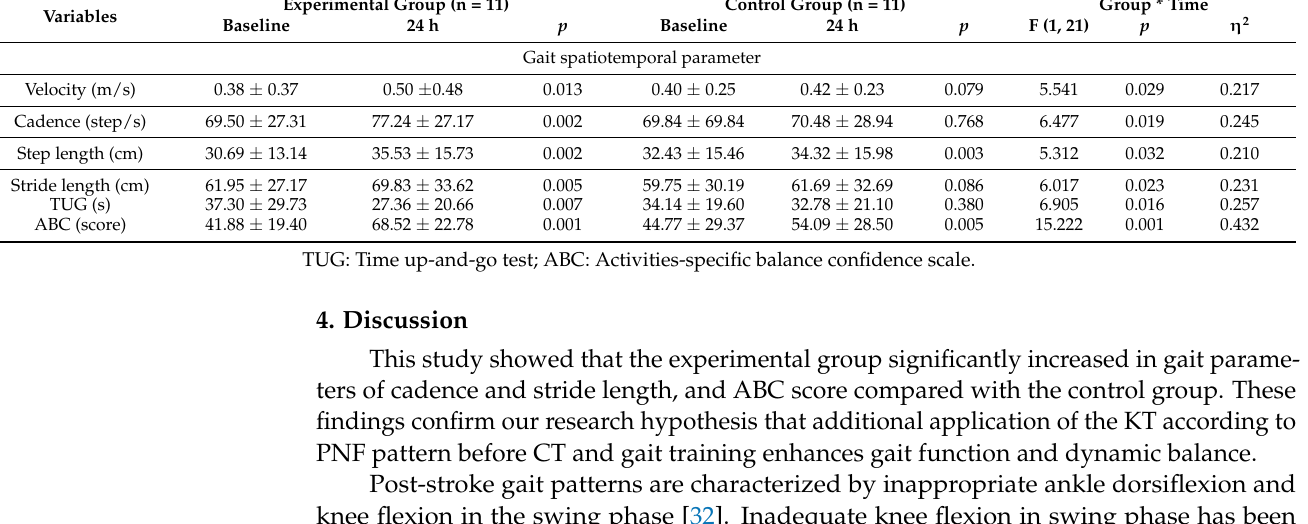
Table 2. Comparisons of gait ability and confidence variables between before and after intervention.